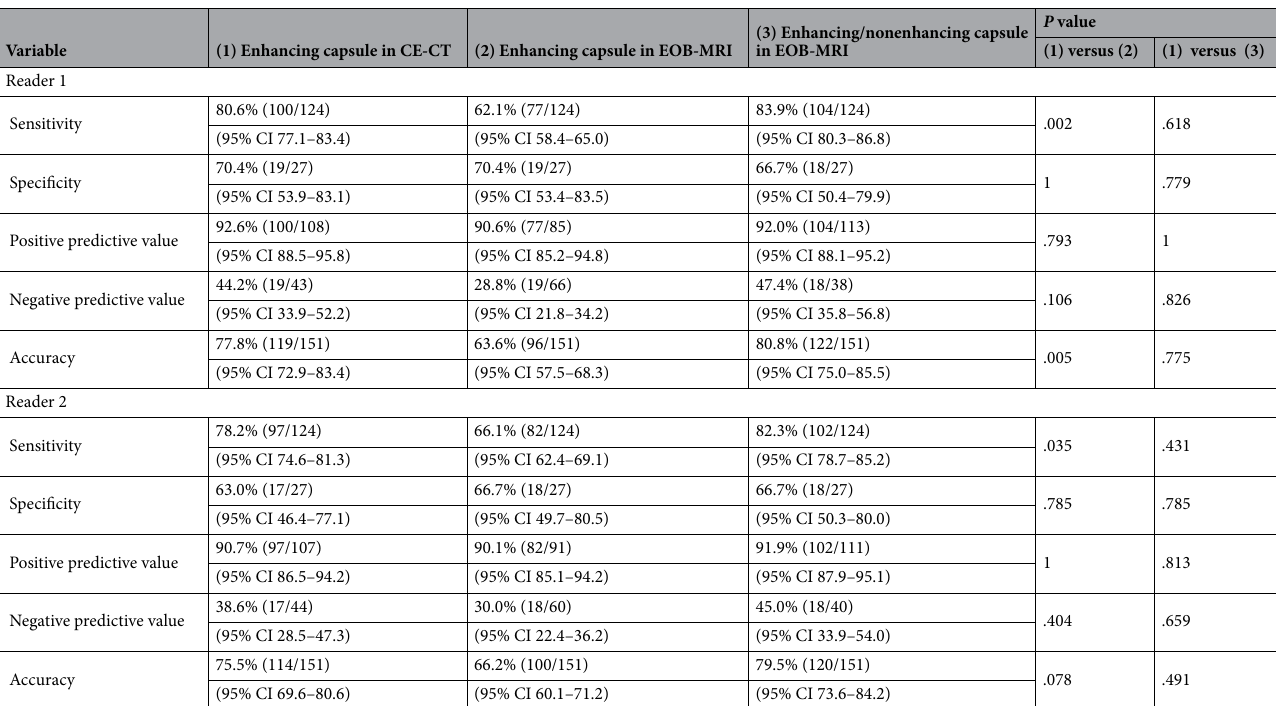
Table 4. Diagnostic performance for the Presence of Histological Capsule in HCCs among Three Imaging Features. Data are expressed as frequency (count). 95%CI 95% confident interval, CE-CT contrast-enhanced CT, EOB-MRI gadoxetic acid-enhanced